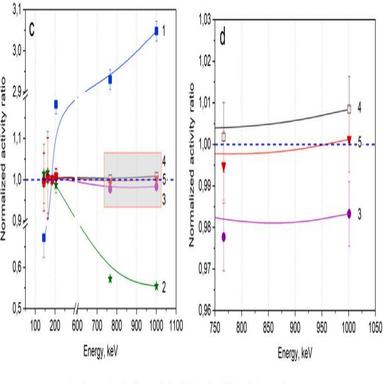
Line activity consistency evaluation.